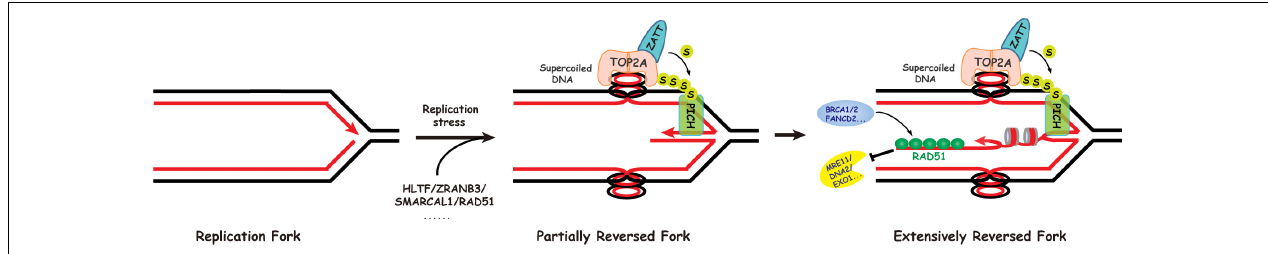
FIGURE 2 | Replication fork reversal occurs via a two-step mechanism. In the first step, SMARCAL1, HLTF, and ZRANB3 cooperate with RAD51 to initiate limited replication fork reversal, generating positive superhelical strain in the newly replicated sister chromatids. The initial fork reversal may be helped by the positive supercoiling ahead of the replication fork created during replication. In the second step, DNA topoisomerase IIalpha (TOP2A) promotes extensive fork reversal, on one hand through resolving the resulting topological barriers, and on the other hand via its role in recruiting the SUMO-targeted DNA translocase PICH to stalled replication